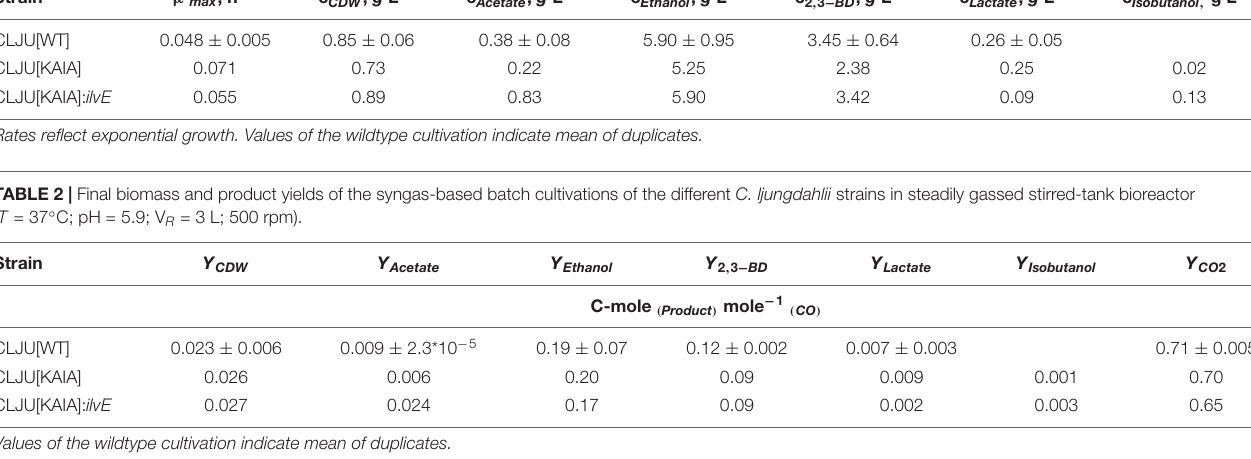
FIGURE 2 | Syngas batch cultivation of CLJU[WT] in a stirred bioreactor with continuous gas supply. Depicted are concentrations of cell dry weight and acetate (A) , ethanol and 2,3-butanediol (B) , lactate and isobutanol (C) , and gas uptake (D) of two independent experiments (circles and diamonds). Two growth phases I (blue) and II (red) were identified. Statistical details are given in the Supplementary Material ( Supplementary Table 1 ). TABLE 1 | Maximal growth rates and final by-product concentrations of the syngas-based batch cultivations of the different C. ljungdahlii strains in a steadily gassed stirred bioreactor. Strain